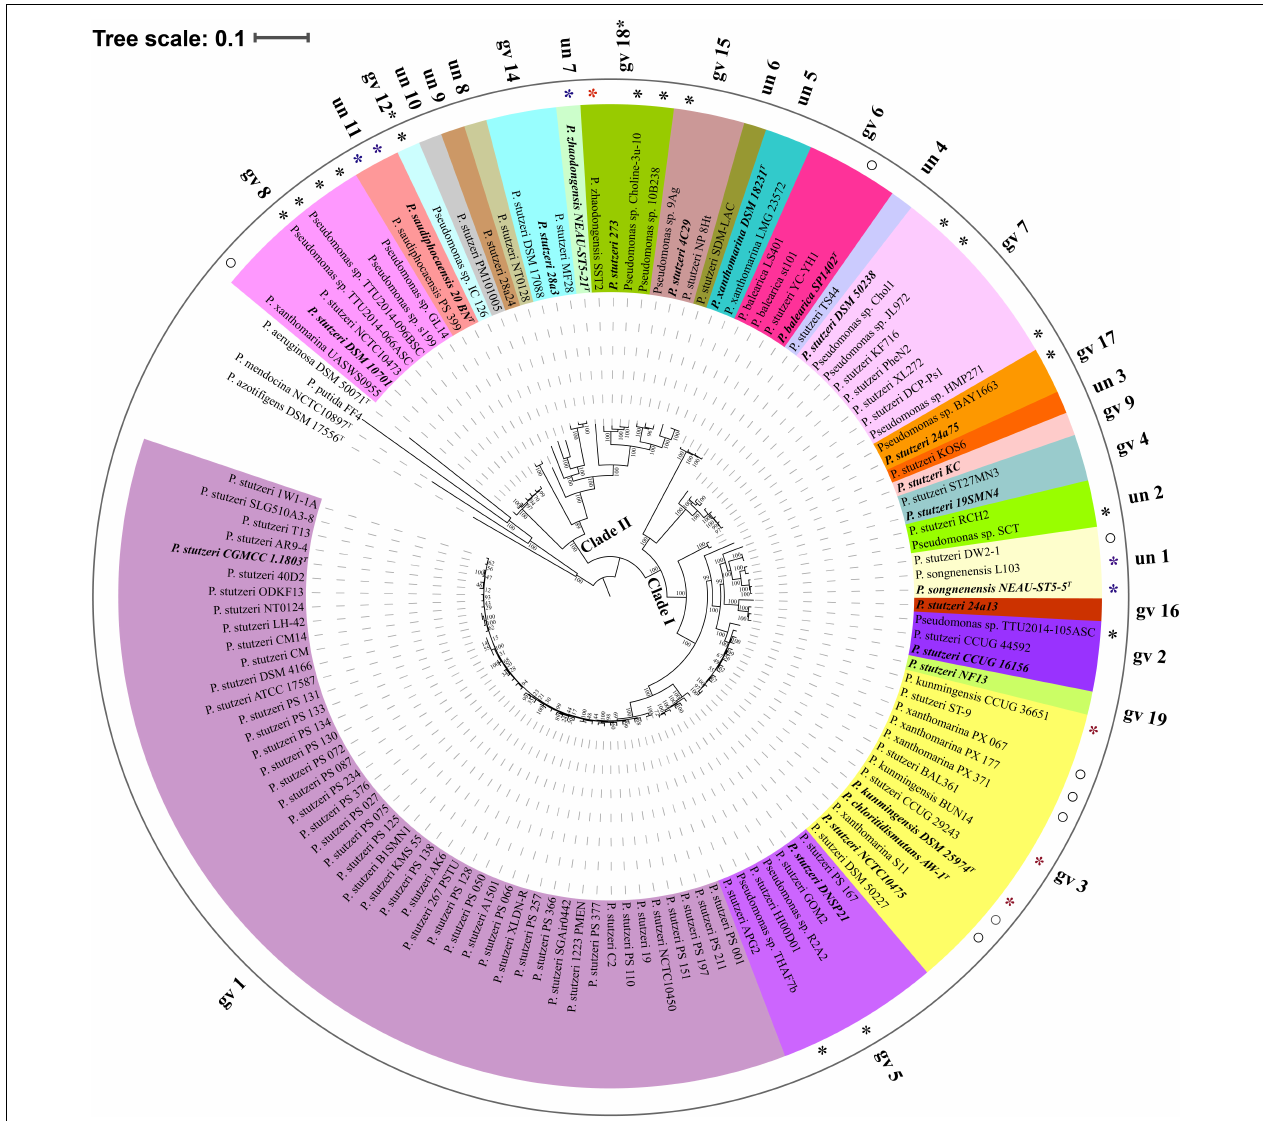
FIGURE 2 | Phylogenetic tree based on the maximum-likelihood method implemented in RAxML. The phylogenetic tree was reconstructed using 524 single-copy orthologous genes shared by 123 P. stutzeri strains and four outgroup strains ( P. aeruginosa DSM 50071 T , P. azotifigens DSM 17556 T , P. mendocina NCTC10897 T and P. putida FF4). This tree was re-rooted with four outgroup strains using iTOL. 27 groups are marked with different colors and numbers. Type strains and the reference strains of each genomovar are marked with bold italic font. Asterisks denote 25 newly identified members of P. stutzeri ; blue asterisks represent newly identified genomovars of P. stutzeri , and red asterisks and hollow circles denote strains with mistakes in nomenclature. Scale bar corresponds to 0.1 estimated nucleotide substitutions per